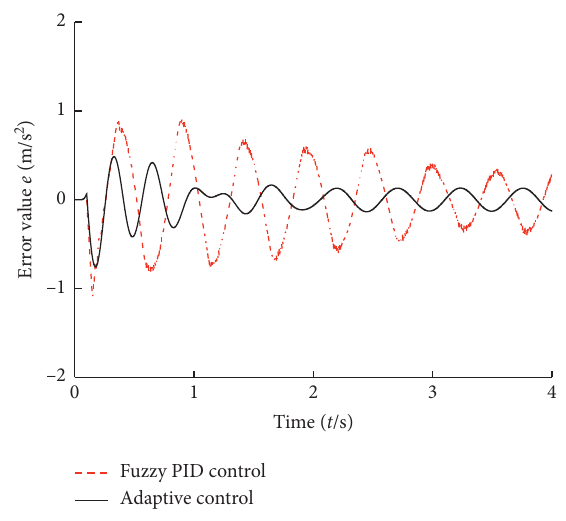
Figure 11: Error curve